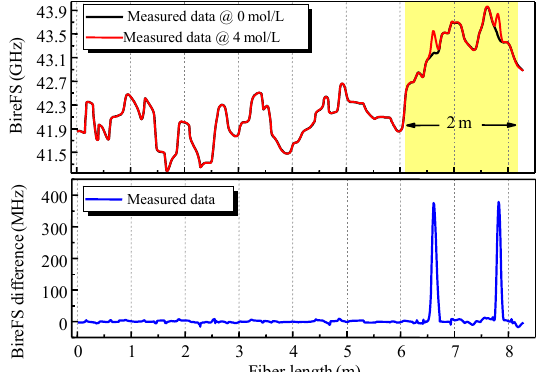
Fig. 15 Distributed measurement capability verification experiment with two salinity measuring segments in a 2-m coated FUT